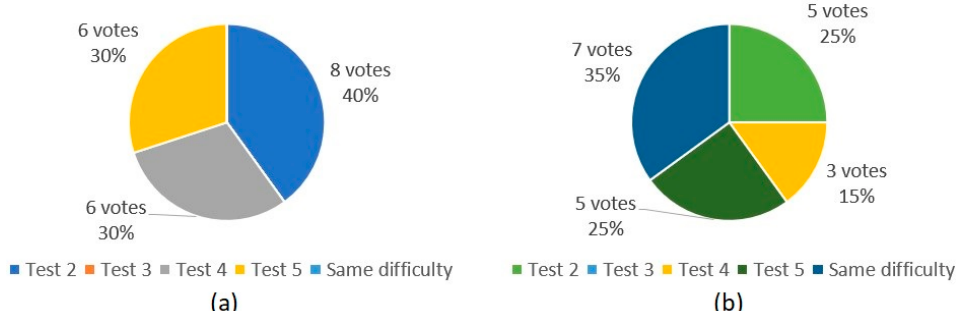
Figure 11. ( a ) Answers of the volunteers when questioned about which test was the easiest to identify the virtual texture on the touchscreen (tests 2 to 5). ( b ) Responses of the volunteers when inquired about which of the tests 2 to 5 was the easiest to describe the textures in it. According to survey questions from Appendix A.